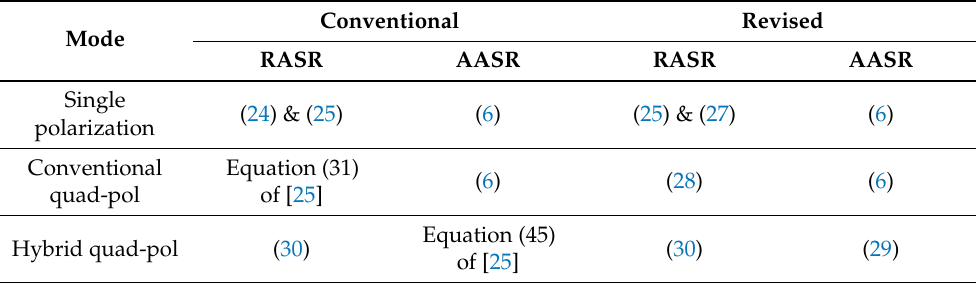
Table 3. Equations for the conventional and revised RASR and AASR for the SAR with waveform